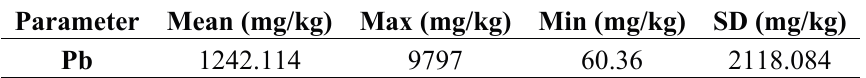
Table 1. Statistical parameters of soil Pb content in the study